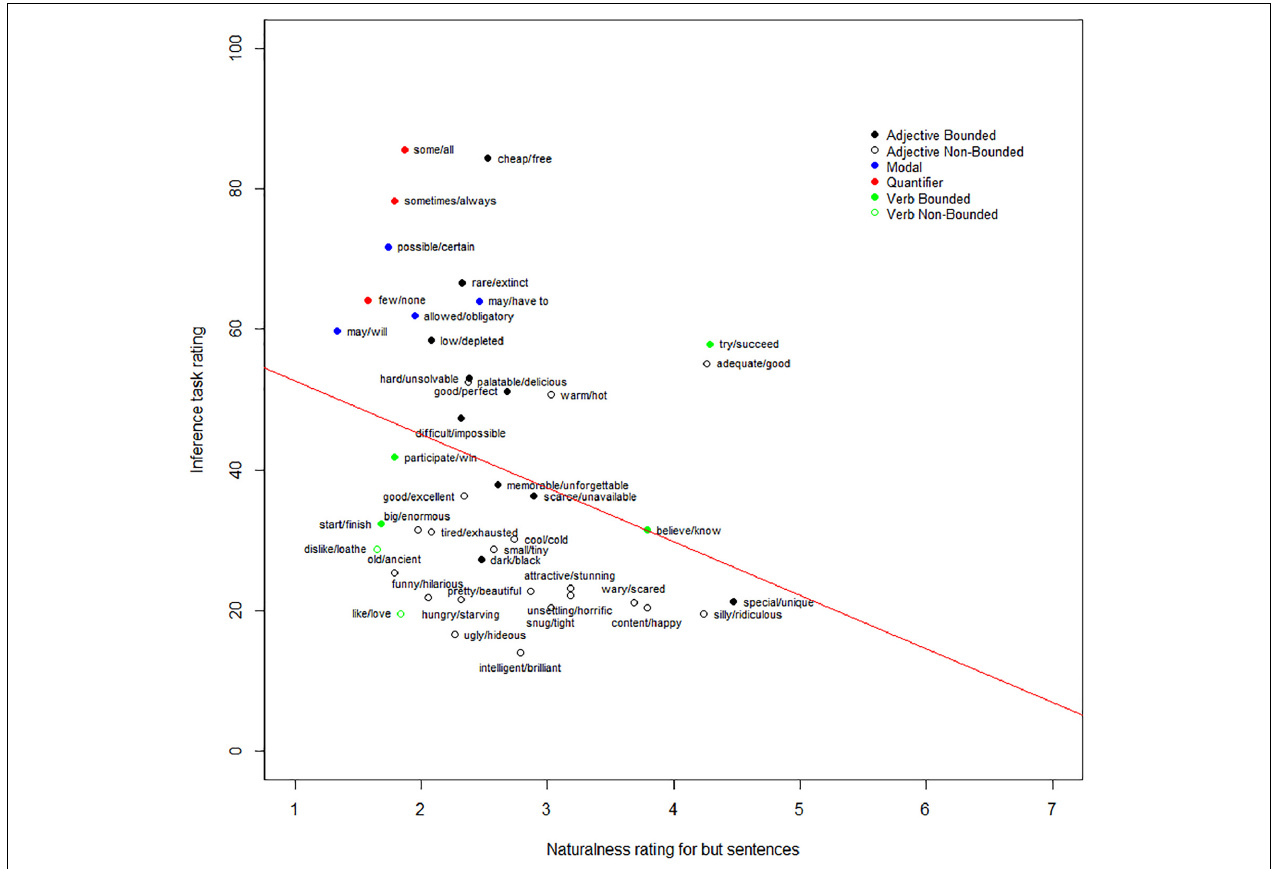
FIGURE 4 | Negative correlation between the absence of homogeneity and inference rate.